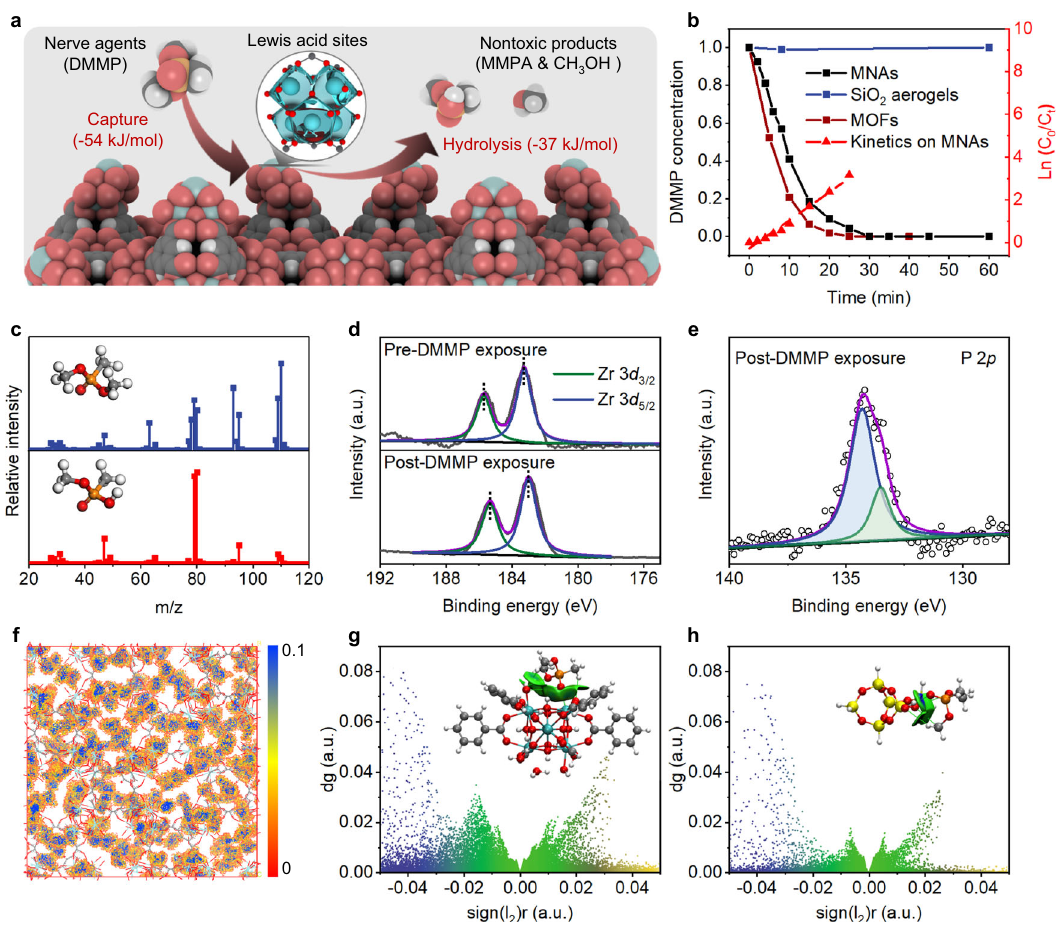
Fig.4|Adsorptionandhydrolyticdegradationreaction.a Schematicillustration of the captureand hydrolysiseffectsoftheMOFsurfaceinMNAs. b Concentration curvesofDMMPanddetoxi fi cationkinetics. c MSspectraofDMMPandMMPA.XPS spectra of Zr 3 d ( d ) and P 2 p ( e ) on MNAs. f MD simulation of DMMP density distribution in MOFs. Non-covalent interactions of DMMP/MOFs ( g ) and DMMP/